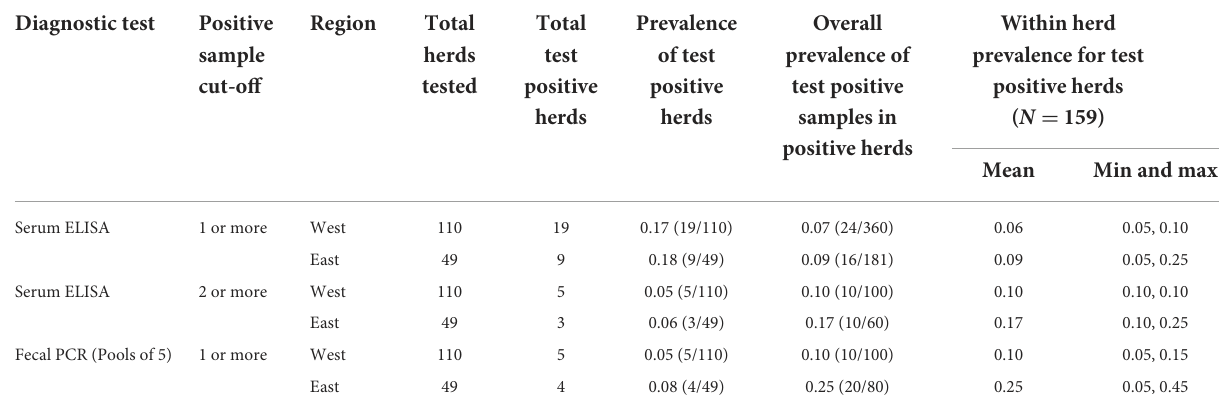
TABLE 3 Comparison of the proportion of MAP positive herds defined by either a 1 or more or 2 or more positive sample cut-off as well as the proportion of MAP positive samples within herds and the average within herd prevalence of MAP based on testing with serum ELISA and fecal PCR (pools of 5 and individual samples).